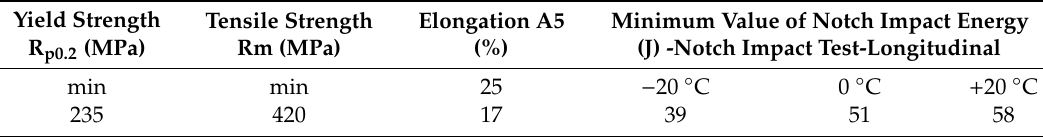
Table 2. Mechanical properties for steel P 235 TR.